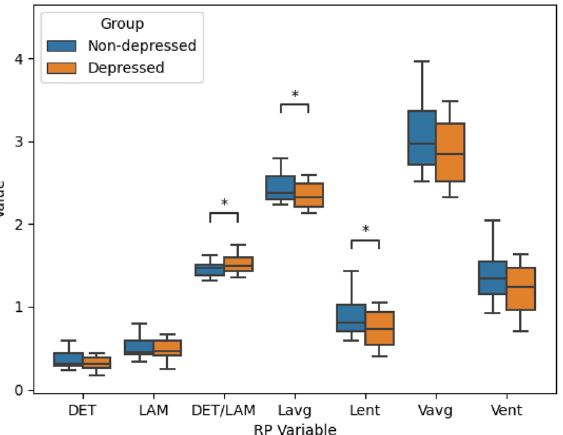
Figure 5. Box plots showing the differences between the non-depressed and depressed groups for the different recurrence plot variables. Significant differences ( p < .05 ) are marked with asterisks ( ∗ ).